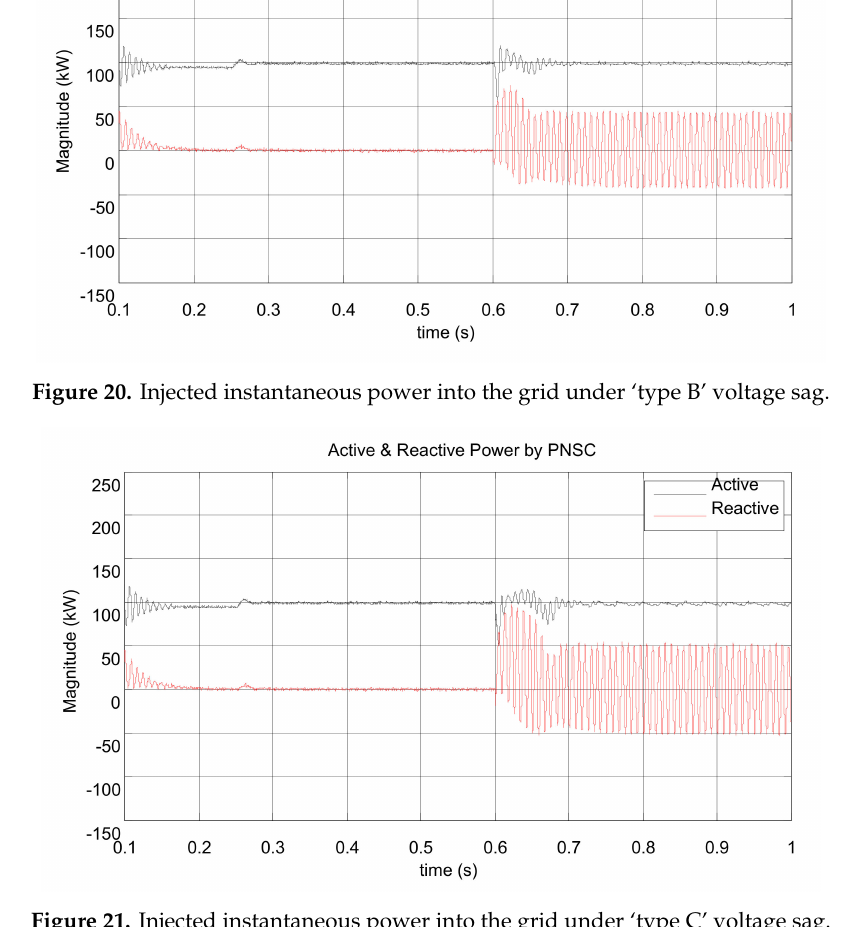
Figure 21. Injected instantaneous power into the grid under ‘type C’ voltage